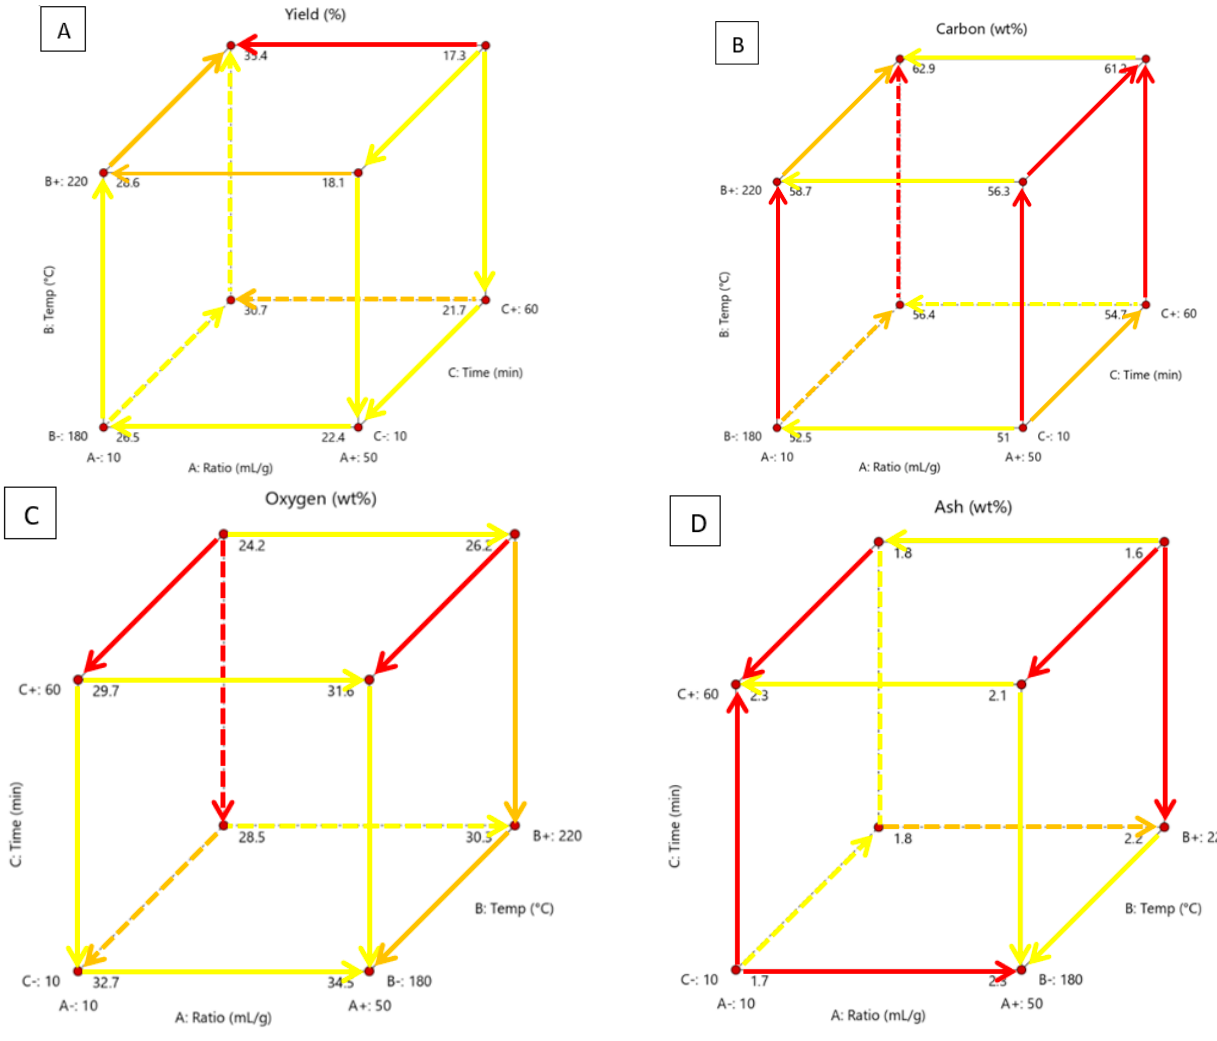
Figure 4. cubic display of the effect of process temperature, solution ratio and residence time on ( A ) hydrochar yield, ( B ) carbon content, ( C ) oxygen content and ( D ) ash content, with highlighted relationships and direction of development.